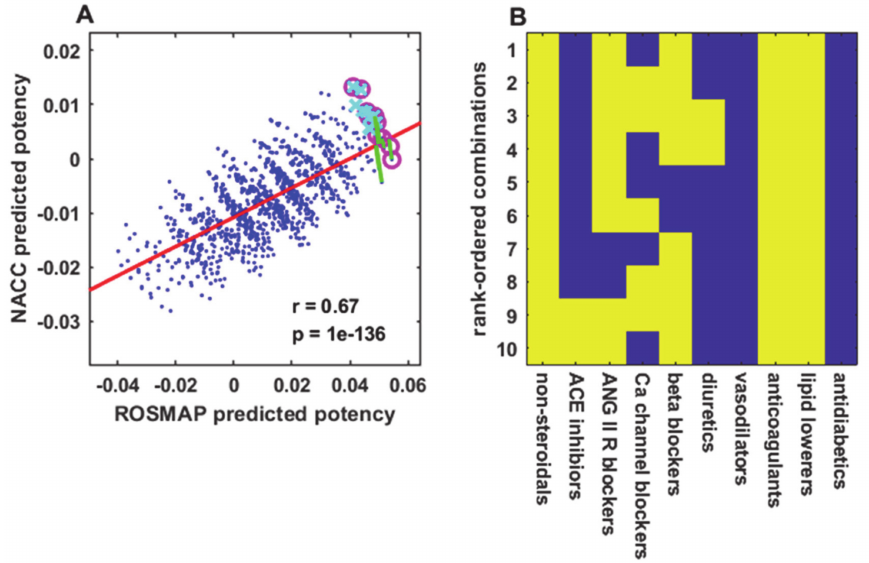
Figure 5. Predicting potent drug combinations jointly from ANNs trained on the ROSMAP or NACC datasets for the 1024 combinations of the 10 drug categories that do not include estrogen/progestin or target cognitive ability or mood. ( A ) The potencies predicted by ANNs trained on the ROSMAP or NACC datasets are highly significantly correlated. The ten best drug combinations as determined jointly in terms of linear regression, sum of potency, or sum of rank of potency as predicted by ANNs trained separately on the ROSMAP or NACC datasets are shown as green line segments, magenta o’s, or cyan x’s, respectively. ( B ) The top ten drug combinations are ranked according to linear regression (1 is highest) and displayed as a heat map (yellow, drug present; blue, drug absent). Each column represents one of the 10 drug categories. The top ten combinations include NSAID, antihypertensive, anticoagulant, and lipid-lowering